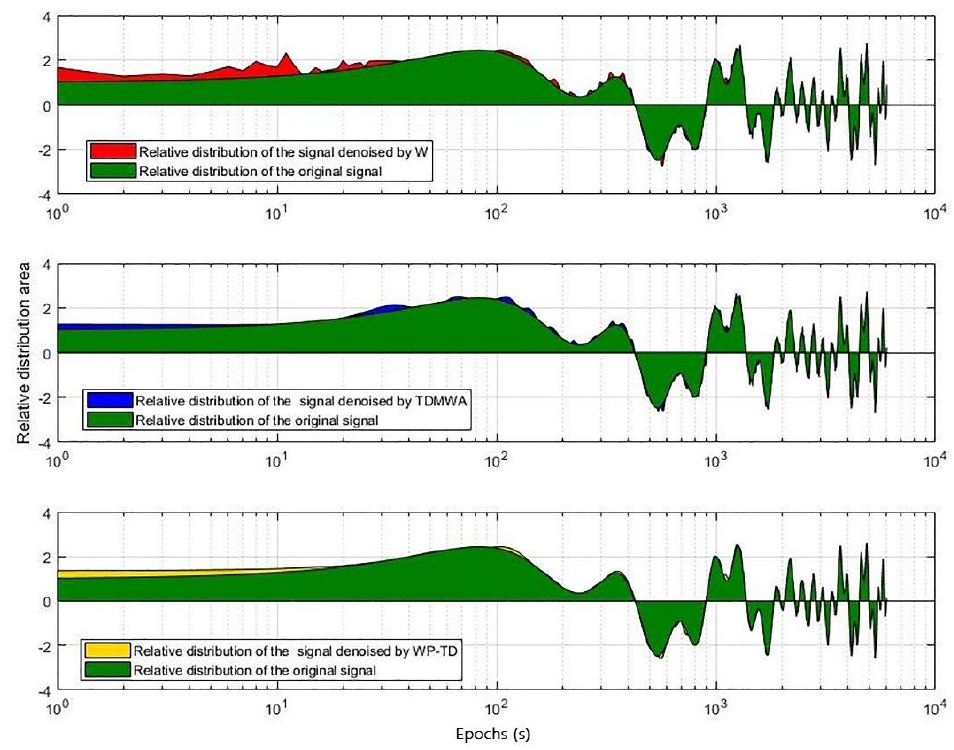
Figure 4. The relative distribution of the signal denoised by the three different algorithms with the original signal.